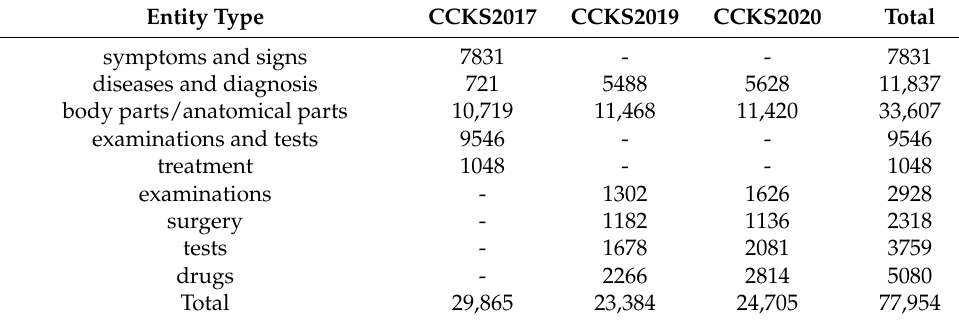
Table 1. Entity statistics of the three